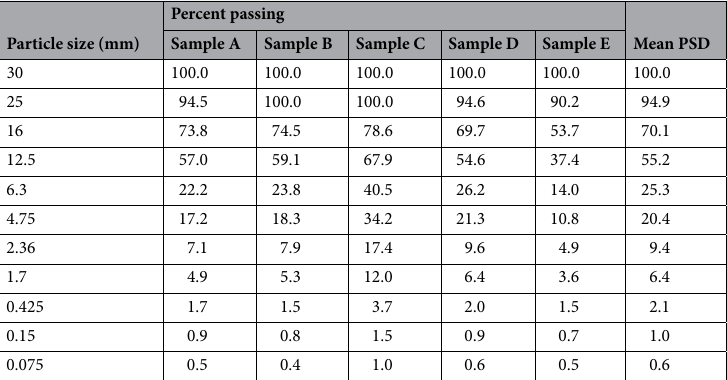
Table 2. Particle sizes and percent passing in each individual soil sample.